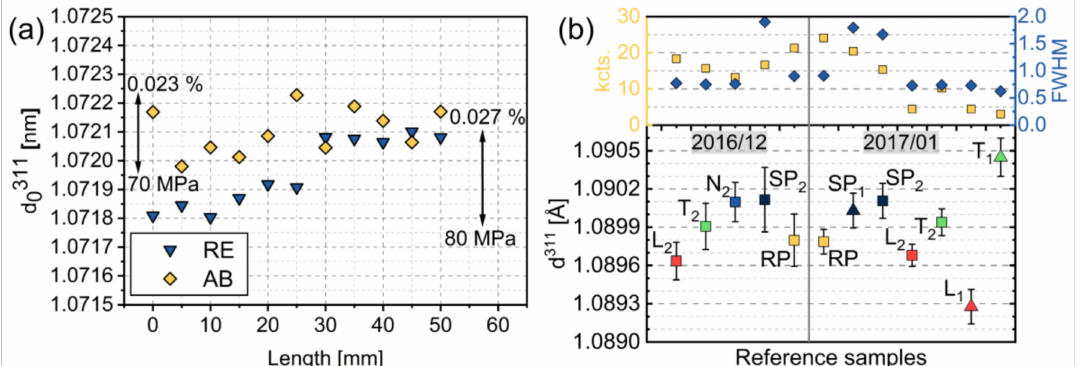
Figure 9. d 0311 values extracted from d 311 versus sin 2 ψ plots ( a ) and from raw powder (RP), filings (SP) and cuboids (L, T, N) ( b ). Data taken from